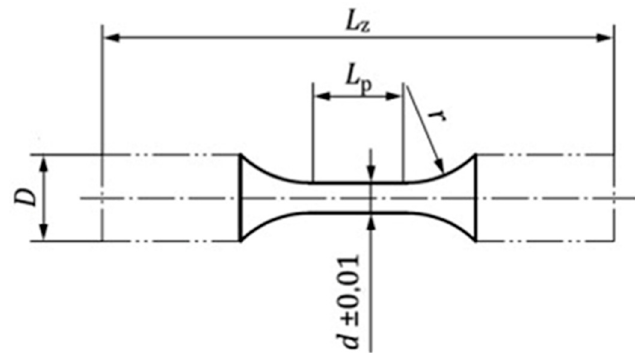
Figure 1. Technical drawing of the AlSi10Mg tensile and fatigue specimens (ISO 1099:2017).